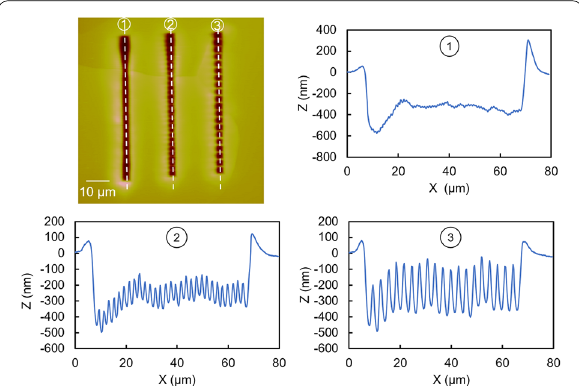
Figure 13 a AFM image and the corresponding cross-sections of the experimental results for the one array indentations with the rotation angle of 45° and the spacings of b 1 μm, c 2 μm and d 3 μm